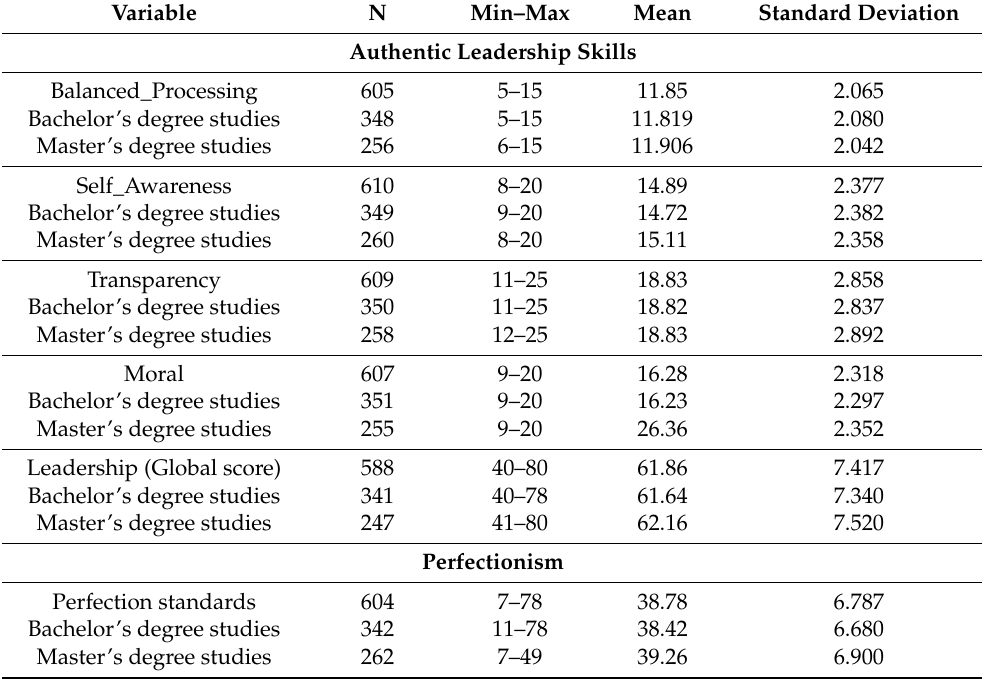
Table 1. The profile of respondents in terms of authentic leadership skills and perfectionism. Variable